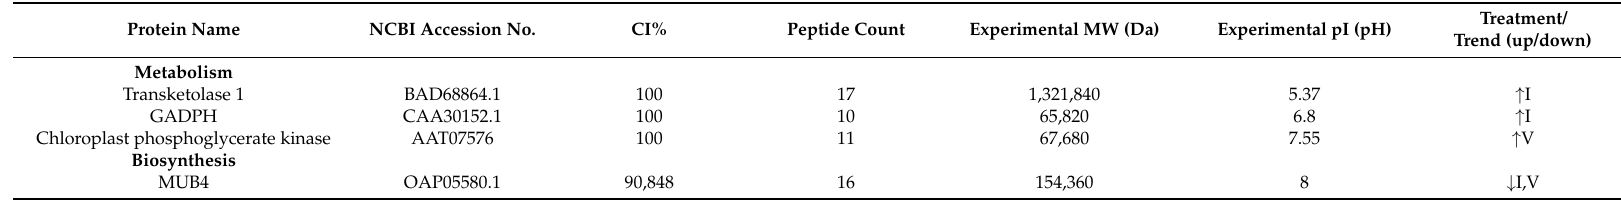
Table 2. MS/MS identification of differentially expressed proteins under non-infected insect and virus-infected insect treatments, only in Fedearroz 2000 variety (relative abundance). Plants were cultivated in a growth chamber under 12/12 h light/dark cycle at a temperature of 25 ◦ C, and relative humidity of 77%. The plants were irrigated daily with water for approximately 30 days to keep the soil moist. The unstressed and stressed plants were kept in the same growth chamber. CI % = protein score; proteins with 55 or more were considered successfully identified. Treatment: I = non-infected insect, V = virus-infected insect. Trend: increase ↑ /decrease ↓ respect to control